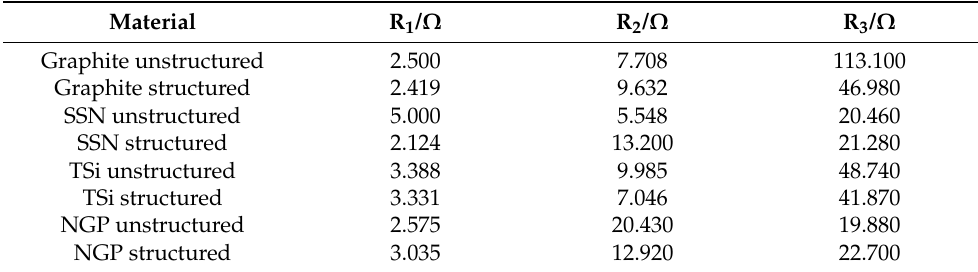
Table 8. Resistances of the coin cells, extracted from Figure